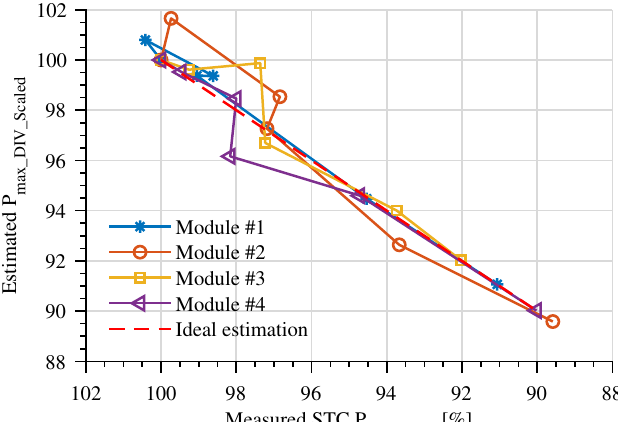
Figure 12. Comparison of P max _ DIV _ Scaled degradation versus measured STC P max of the four mod-